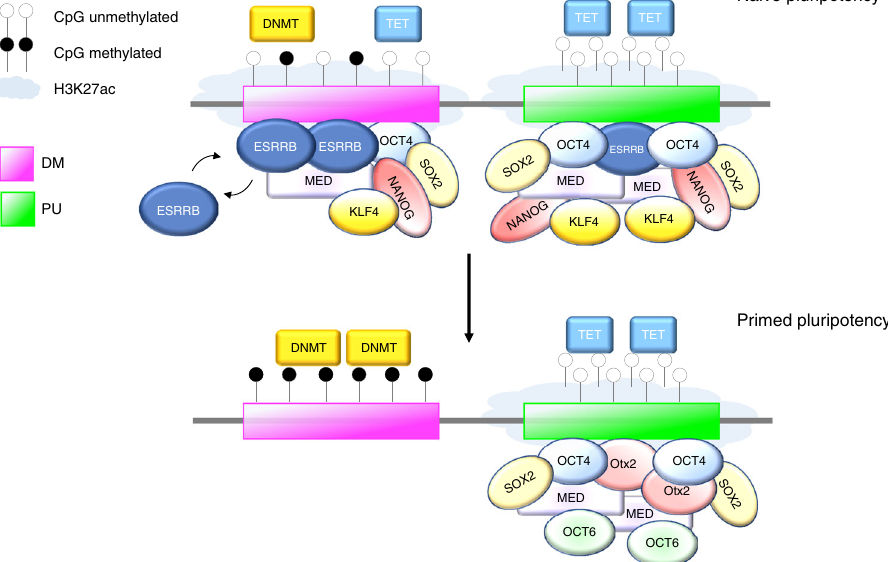
Fig. 7 Proposed model depicting the role of ESRRB at SEs in pluripotent stem cells. In naive pluripotent cells, the dynamic expression and binding of the nuclear receptor ESRRB instigates a metastable state at DM subregions (magenta) by counteracting DNMT3s activities as re fl ected in cell-to-cell CpG methylation heterogeneity. In contrast, PU subregions (green) consist of hotspots of core and naive pluripotency TF binding and remain stably unmethylated. Upon ESRRB depletion and/or during the establishment of primed pluripotency, DM subregions are rapidly and selectively destabilised with the loss of mediator occupancy and consolidation of CpG methylated state, leading to their decommissioning in primed epiblast cells. In contrast, PU subregions remain unmethylated and highly bound by core and primed pluripotency TFs, indicative of their continued enhancer activity. The partitioning of enhancer units within SEs as constitutively active (PU) or decommissioned (DM) proposes a mechanism by which the pluripotency transcriptional programme can be partially reset during the naive-to-primed transition, preserving pluripotency as cells prepare for subsequent differentiation. Core (OCT4 and SOX2), naive (ESRRB, KLF4 and NANOG) and primed (OCT6 and OTX2) pluripotency TFs are represented along with the mediator protein complexes (MED), DNMT and TET